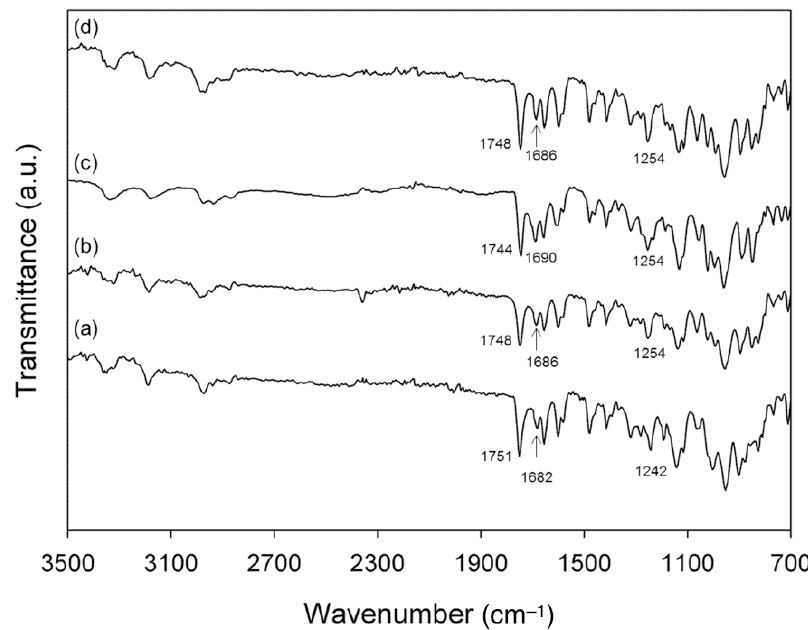
Figure 6. IR spectra of AD/SUC cocrystals, prepared by the precipitation from the AD/SUC = 2:1 solutions: ( a ) form I prepared with PAA; ( b ) form I + II collected after 1 day without additive; ( c ) form II collected after 7 days without additive; ( d ) mostly form II prepared with